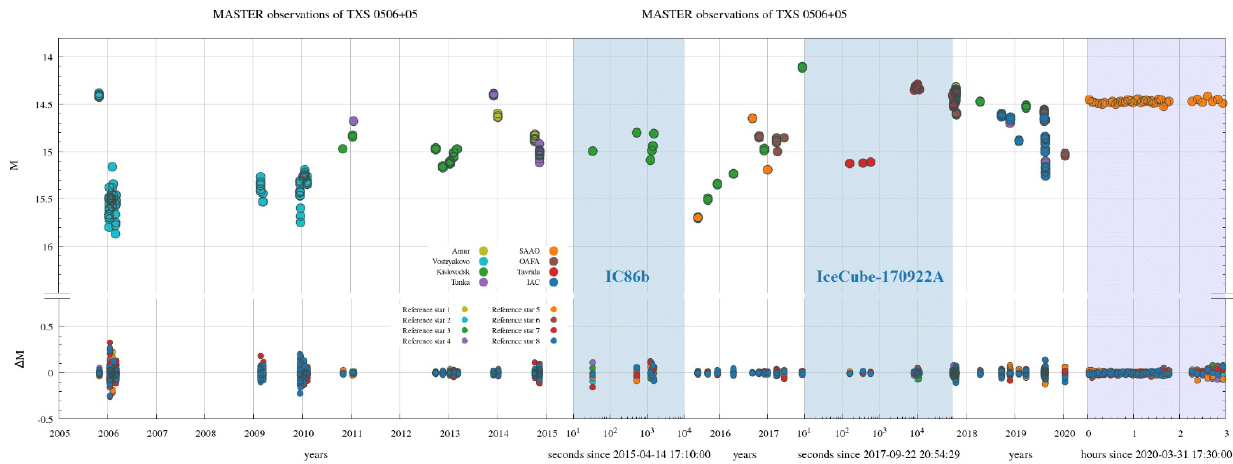
Figure 17. MASTER light curve of the TXS 0506+056 blazar for 16 y. Below, we see the photometry of eight reference stars. The pink and blue panels represent three very narrow episodes in time. One can see the rapid change in the luminosity of the blazar in ~2 times. Finally, the third episode is a uniform blazar monitoring timeline in the first quarter of 2020. Logarithmic time is shown in seconds from the neutrino trigger in pink panel [25] ©MASTER2020.